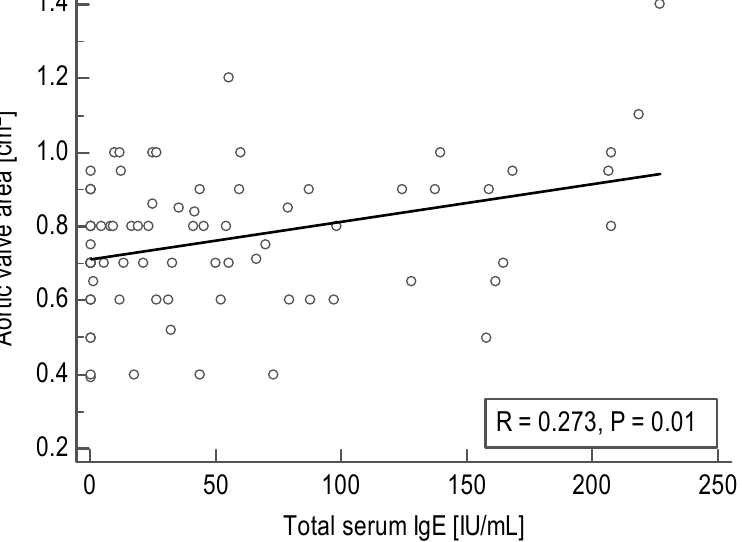
Figure 2. Median aortic valve area in acquired aortic stenosis patients having different genotypes of the high-affinity immunoglobulin E receptor α -subunit locus ( FCER1A ) rs2251746 polymorphism. Boxes range from the 25th to the 75th percentile with a horizontal line at the median and vertical lines extending to the 10th and 90th percentiles. P -values calculated using Mann–Whitney test are given. P -values of less than 0.05 are marked with a star (“*”). 3.3. The Effects of FCER1A Polymorphisms on Total Serum IgE in Acquired AS Patients Finally, we investigated whether FCER1A polymorphisms associated with total IgE in AS subjects. The rs2251746 polymorphism tended to be associated with total serum IgE ( P = 0.09), with the highest values in TT and the lowest in CC homozygotes (Table S4). Furthermore, contrasting carriers of the T allele or TT homozygotes with CC homozy- gotes demonstrated lower IgE in the latter group ( P = 0.03 in both; Table S4). In turn, although TT homozygotes of the rs2252226 polymorphism had the lowest and CC ho- mozygotes the highest total serum IgE values, the differences were not significant (Table